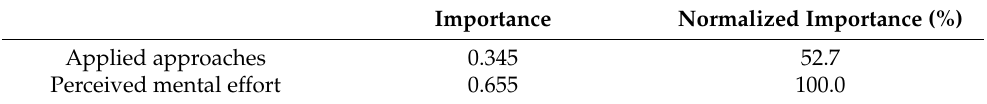
Table 7. Importance and the normalized importance of each predictor of students’ achievement.